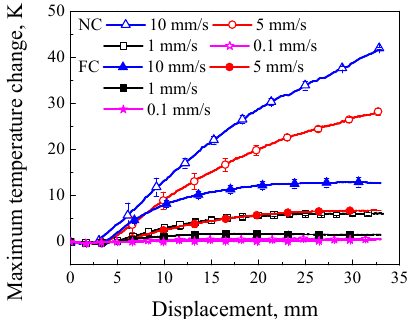
Figure 8. Curves of maximum temperature change and displacement at di ff erent loading rates in the NC and FC conditions.